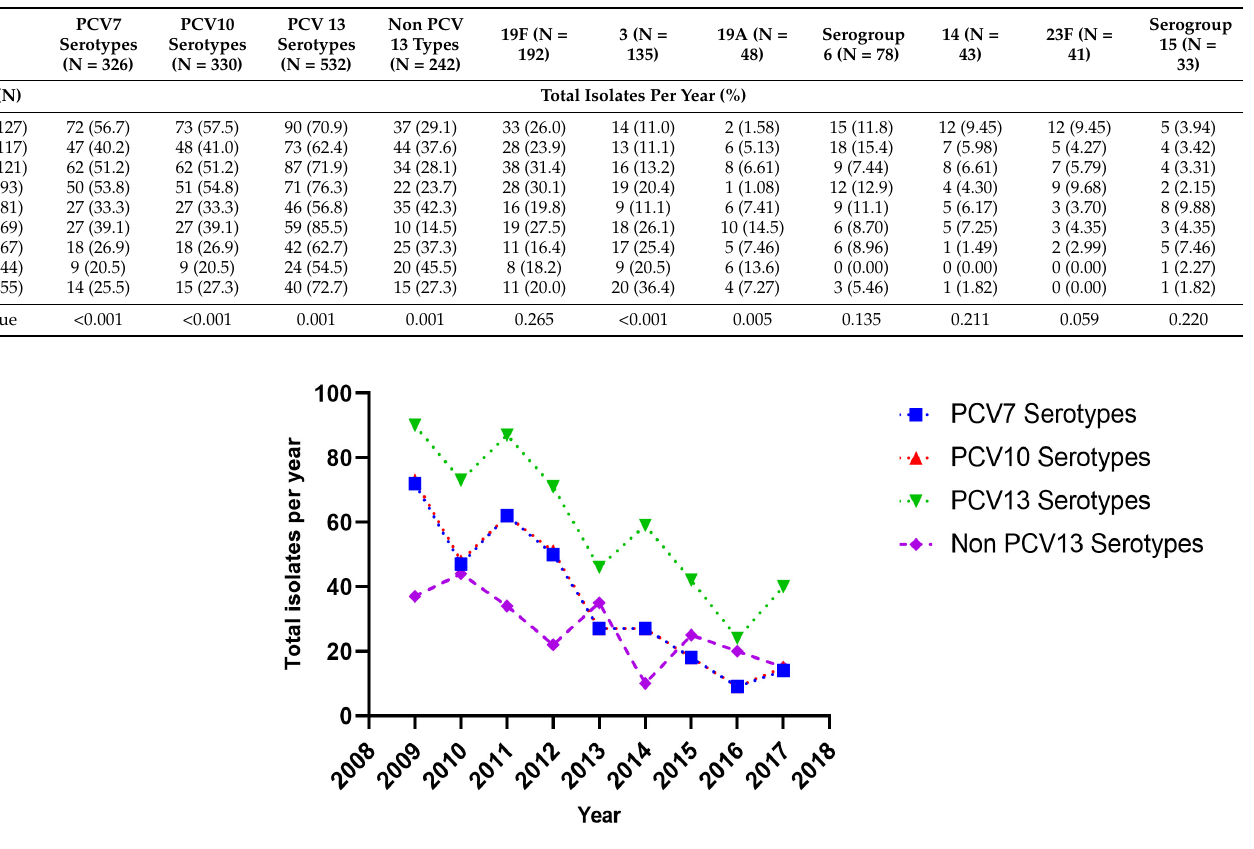
Figure 1. Annual changes in the distribution of the PCV7, PCV10, PCV13 and Non PCV13 serotypes of pneumococci isolated from adult disease. Table 2. Distribution of common serotypes/groups isolated from patients ( p- values by Fisher’s exact test or Chi-square test).